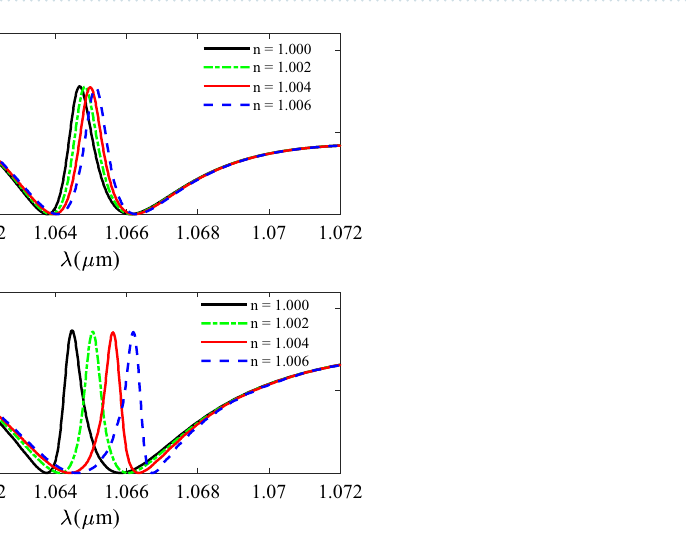
Figure 7. Effect of Λ SWG on ( a ) reflection and Q, ( b ) Sensitivity, and d FOM.